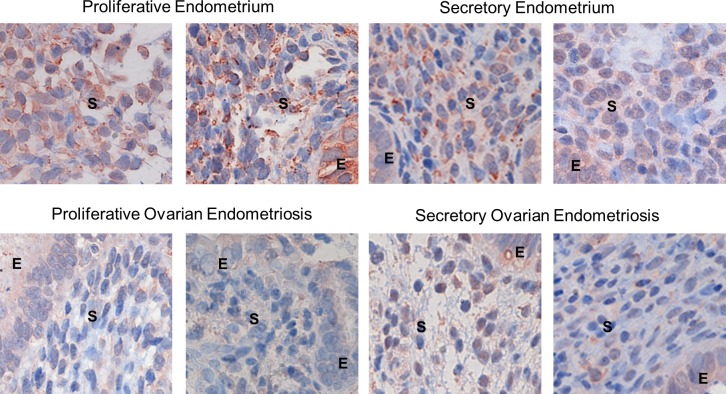
WNT5A protein expression at the whole tissue level.Immunostaining for the WNT5A protein was done on FFPE sections of endometriotic (n = 14) and normal endometrial tissue (n = 14) samples. Representative pictures from control endometrium and endometriotic lesions at proliferative and secretory phase of the menstrual cycle are shown. The stromal = S and epithelial compartments = E are indicated. The results indicate down-regulation of the levels of WNT5A in the stroma of endometriosis vs. control endometrium, independent of the cycle phase.